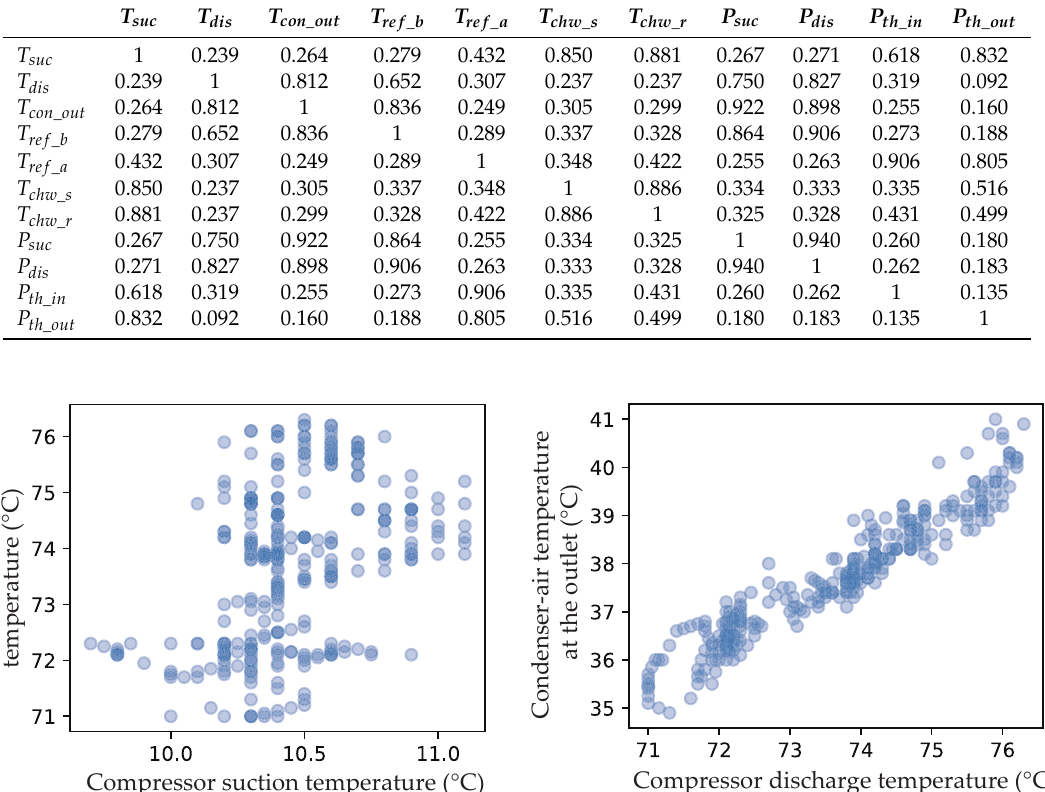
Figure 2. Density plots of T suc and T dis , T dis and T con _ out